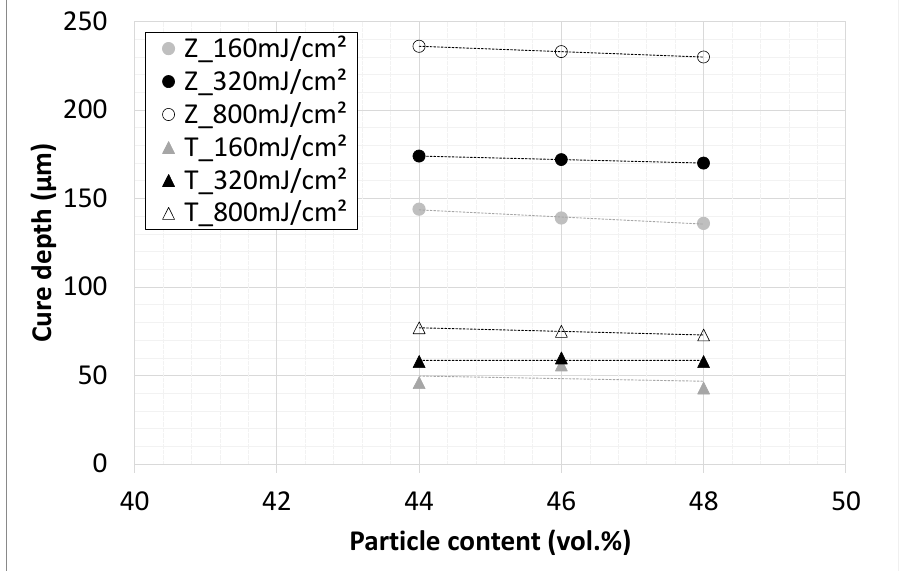
Figure 8. Cure depth (405 nm) depending on particle content; titania (triangles) and zirconia (circles) slurries based on rc2. Based on the achieved results, printing parameters were derived for VPP for the different materials and slurries for printing test samples and validating the development. Starting with cubes, plates, bars and grid plates, first, parameter set-ups were tested, followed by printing more complex designs. After shrinkage characterization, the “core– shell” components introduced in Figure 1 were printed, and green parts are shown in Figure